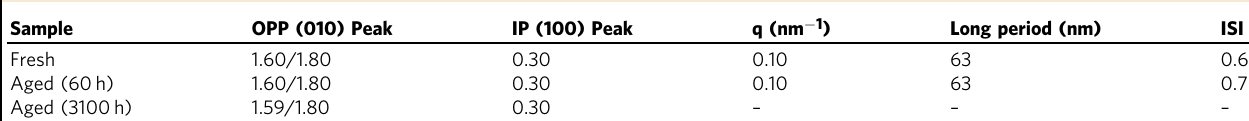
Table 1 Morphological parameters extracted from GIWAXS and R-SoXS measurements.